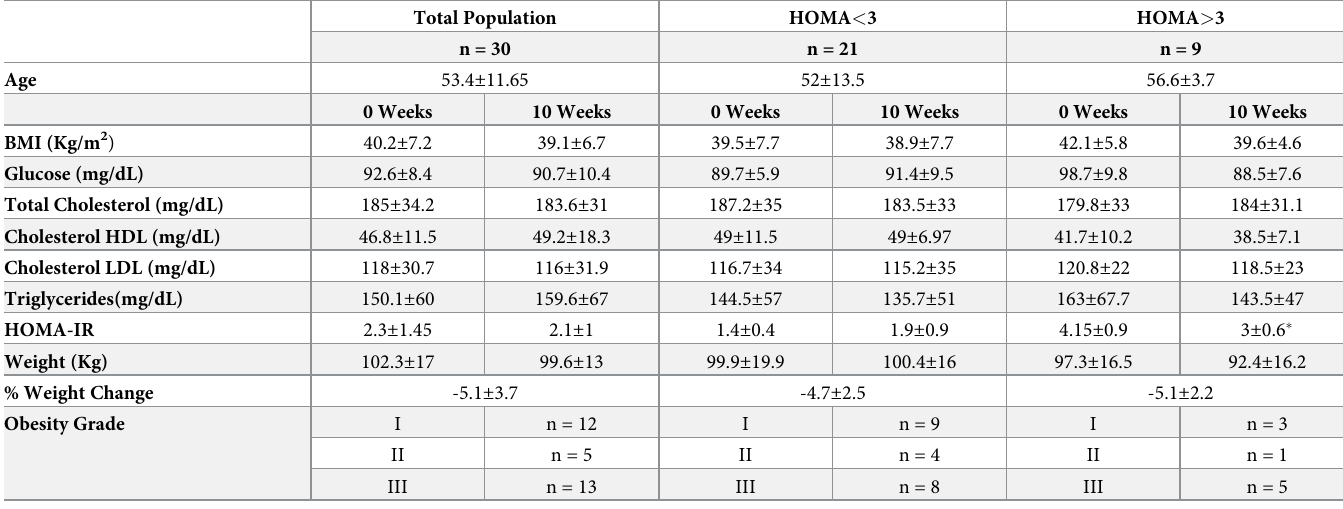
Table 2. Anthropometric characteristics, blood chemistry and HOMA of postmenopausal women treated with Metformin for 10